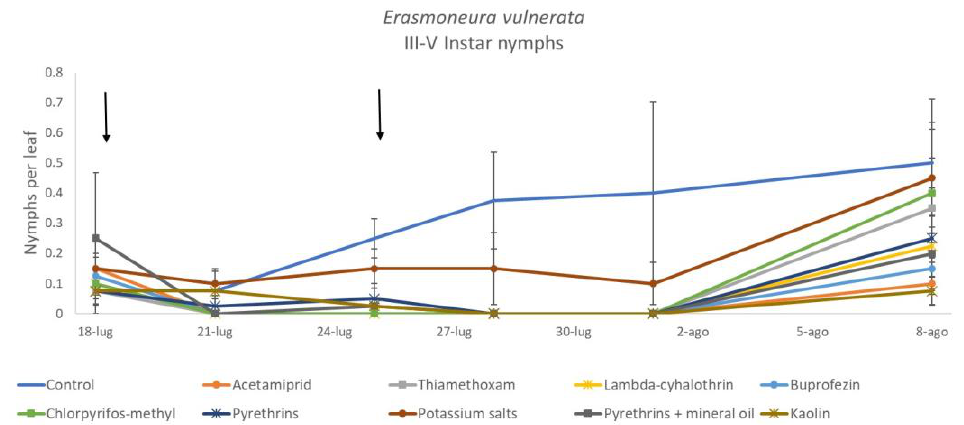
Figure 5. Dynamics of Erasmoneura vulnerata older (III-V instar) nymphs (mean ± std. err.) in the 2017 trial. Insecticides were applied one (first arrow) or two times (second arrow, see Materials and Methods section).